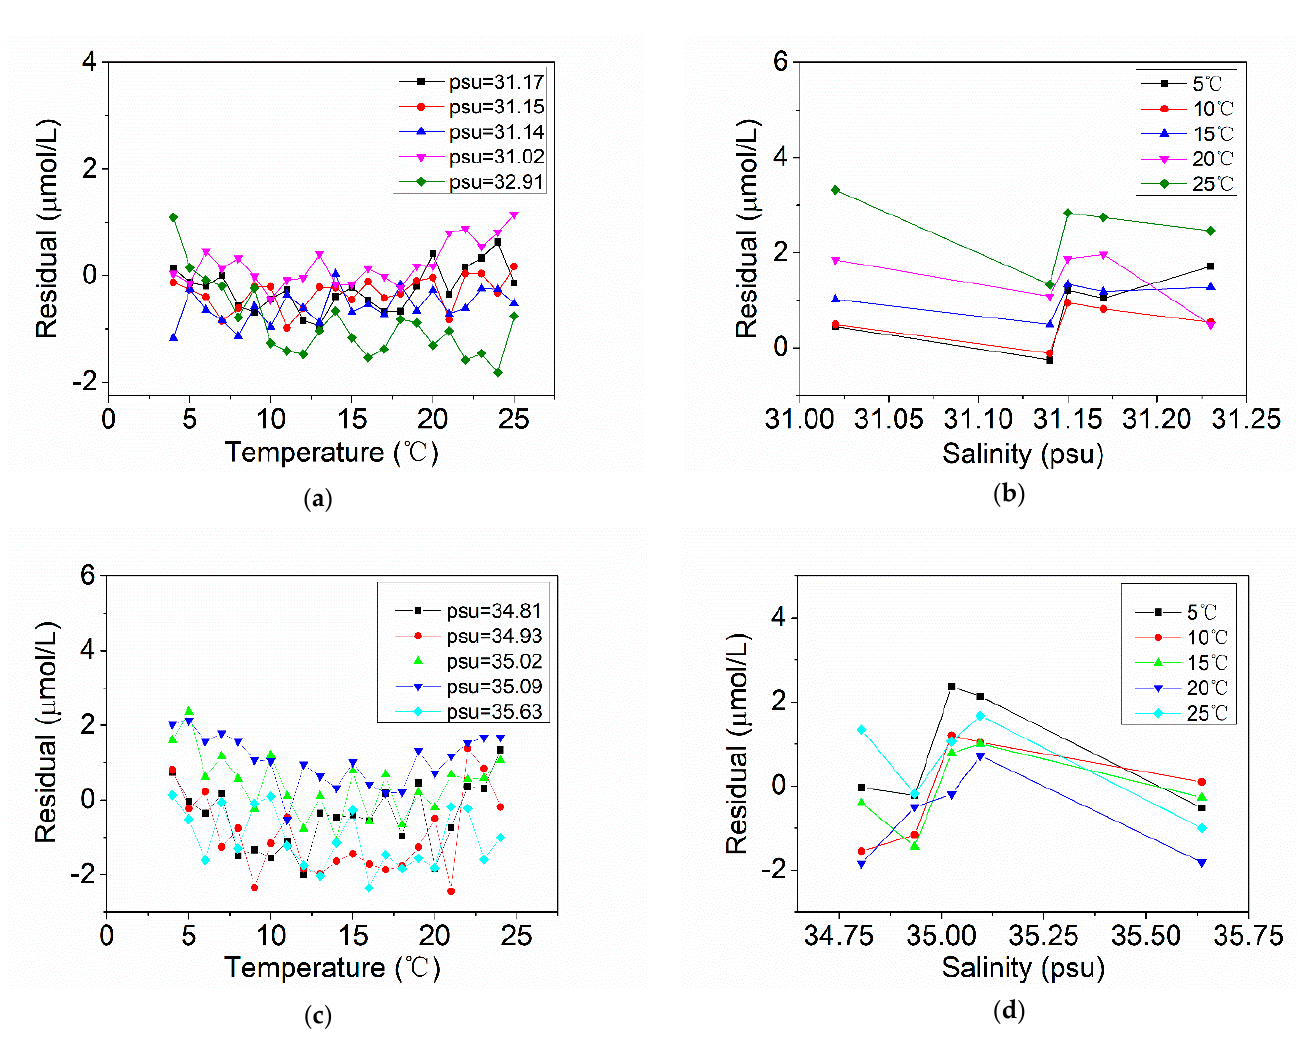
Figure 10. Temperature and salinity dependency results. ( a ) Temperature dependency of Aoshan Bay seawater samples; ( b ) salinity dependency of Aoshan Bay seawater samples; ( c ) temperature dependency of Western Pacific seawater samples; ( d ) salinity dependency of Western Pacific seawater samples.